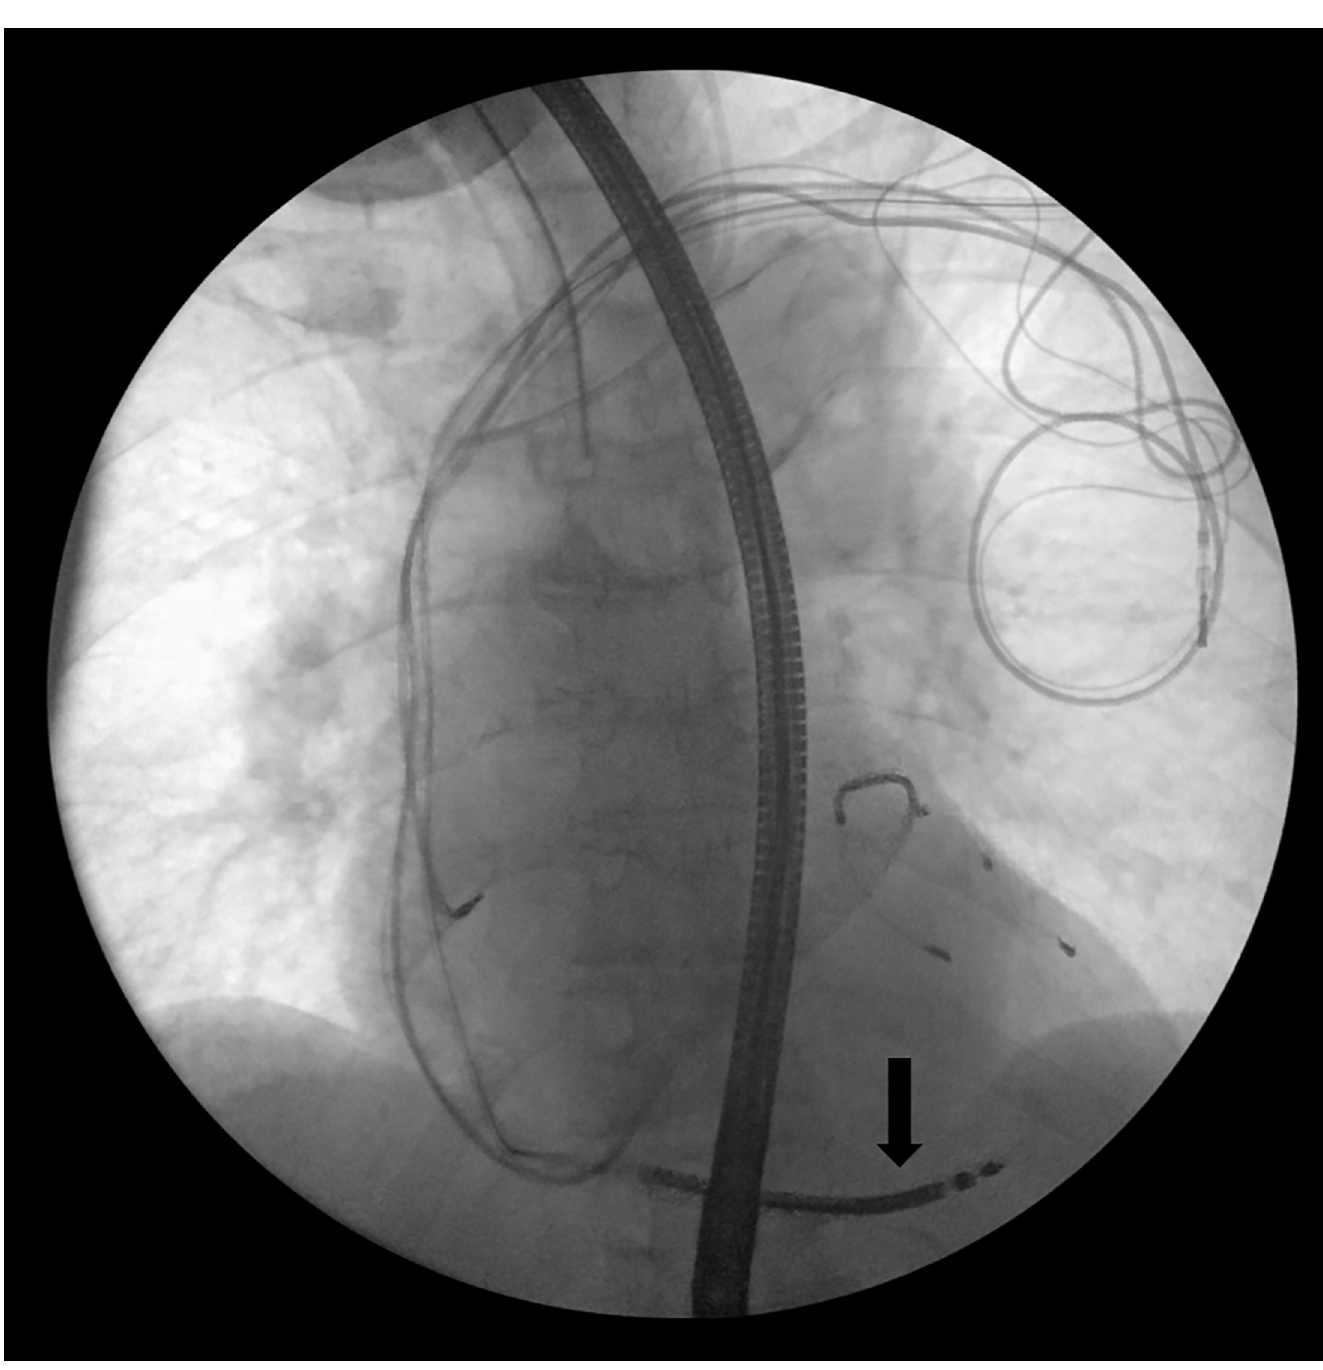
Fig 8. Successful new lead implantation (marked by the arrow) in the right